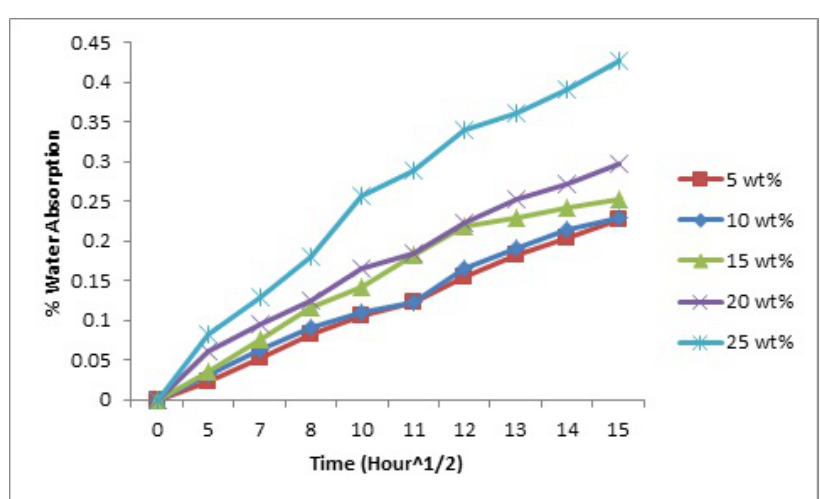
Figure 11: Water absorption versus square root of hours (